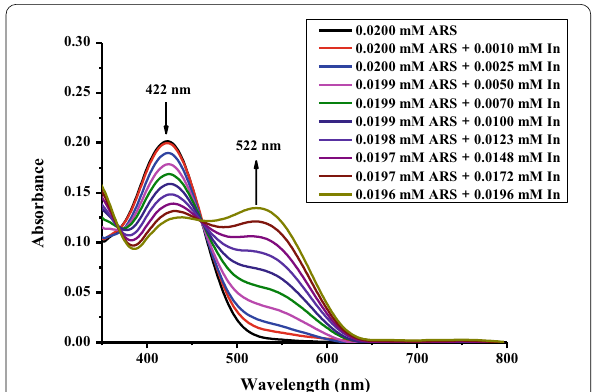
Fig. 1 Interaction between In and ARS at pH 7